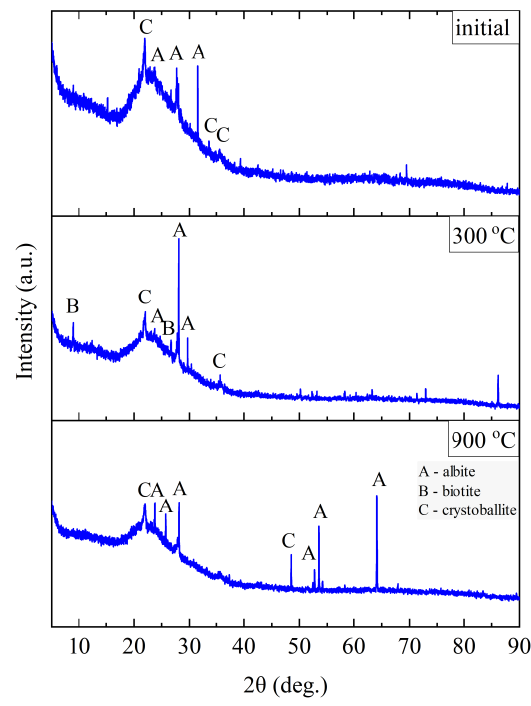
Figure 14. XRD diffractograms for Hungarian perlite ore HP.